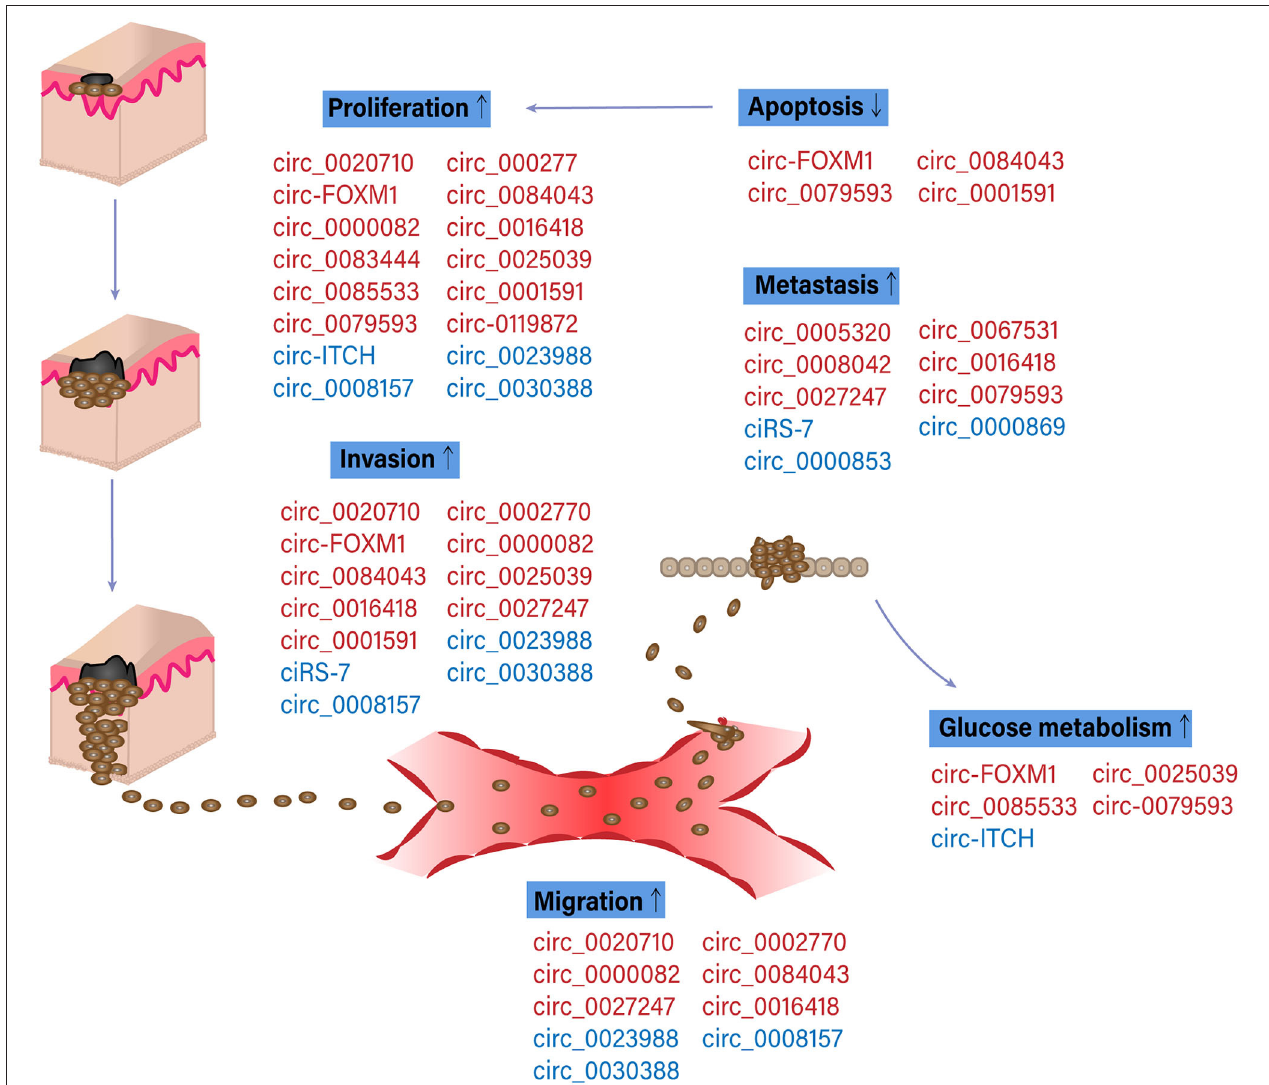
FIGURE 3 | Functions of specific circular RNAs (circRNAs) in melanoma pathogenesis. Schematic diagram of circRNAs involved in melanoma progression. Red and blue color indicated the oncogenic and suppressive functions of circRNAs in different biological processes involved in melanoma progression, respectively. Up and down arrows indicated the activation and inhibition of physiological processes in melanoma pathogenesis, respectively (Bian et al., 2018; Ju et al., 2018; Luan et al., 2018; Wang Q. et al., 2018; Lin et al., 2019; Shang et al., 2019; Zou et al., 2019; Chen J. et al., 2020; Chen Z. et al., 2020; Hanniford et al., 2020; Jin et al., 2020; Lu and Li, 2020; Lu et al., 2020; Qian et al., 2020; Tian et al., 2020; Wei et al., 2020; Liu et al., 2021; Yin et al.,